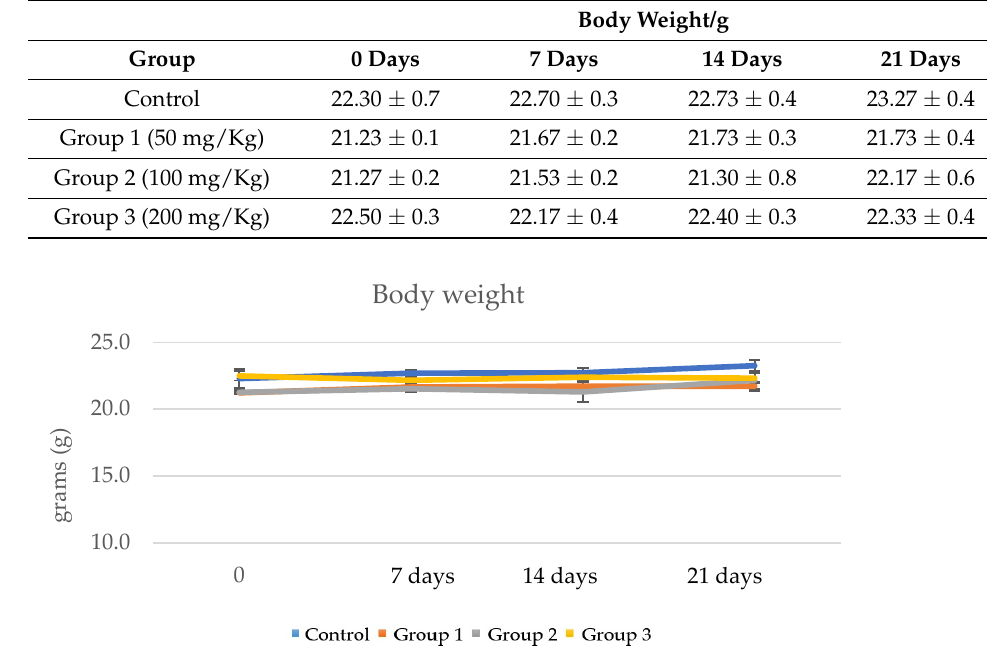
Figure 10. Body weight assessment of animals that received the product for 21 days.